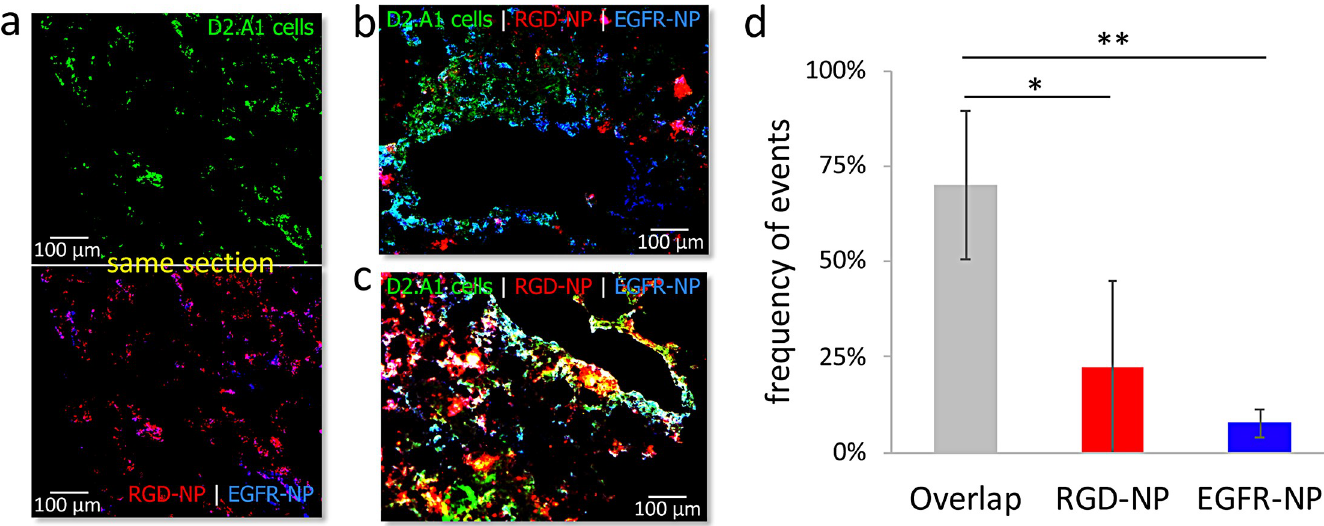
Fig 5. Histological evaluation of the microdistribution of RGD-NP and EGFR-NP nanoparticles in metastasis in the lungs of mice. (a) Representative fluorescence image of lung tissue shows dispersion D2.A1 metastatic cancer cells (top; 20X magnification). After 3 h from injection of a cocktail containing Alexa 350-labeled EGFR-NP and Alexa 568-labeled RGD-NP, the two targeting variants colocalized in locations with metastatic cancer cells (bottom). Different regions with metastatic cancer cells were predominantly targeted by (b) EGFR-NP or (c) RGD-NP (green: D2.A1 cancer cells; red: RGD-NP; blue: EGFR-NP). (d) A pixel-by-pixel quantification indicates individual events for EGFR and RGD-NP or their overlap (n = 3, grouped analysis ANOVA; correct for multiple comparisons using the Holm − Sidak method. P values: � 0.024, ��